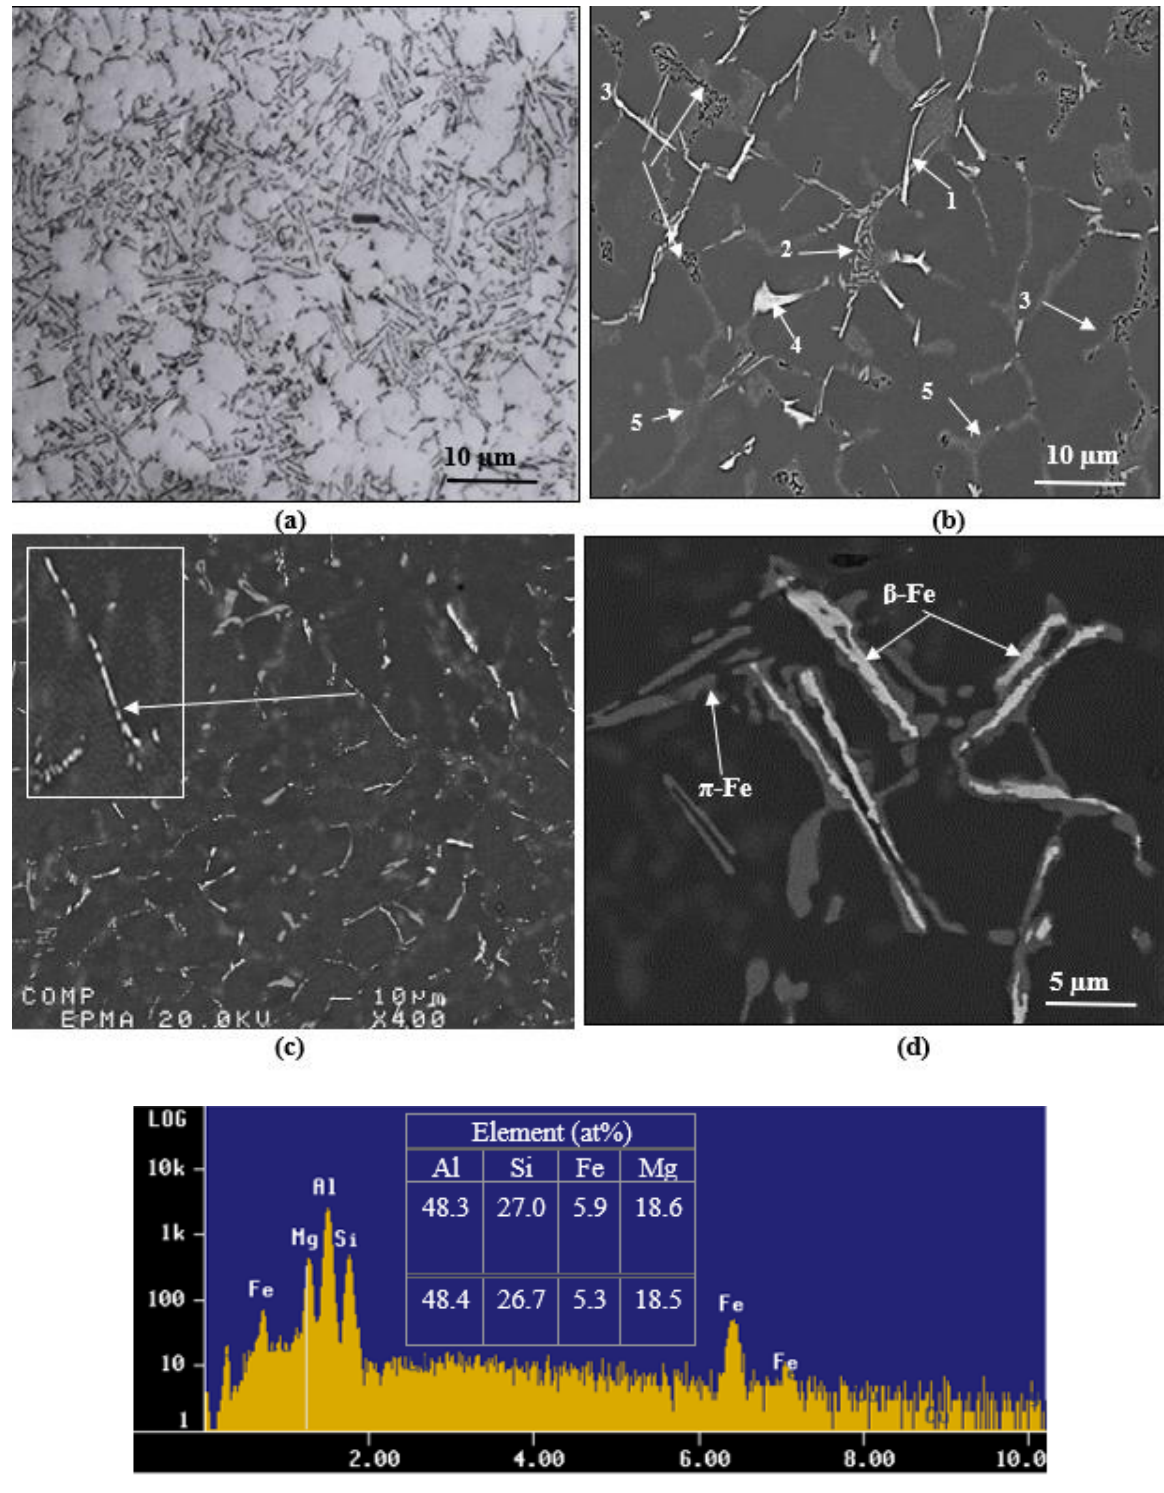
Figure 11. Microstructures of alloy C (800 ◦ C/s) in the: ( a , b ) as-cast, and ( c – e ) solution heat-treated conditions.